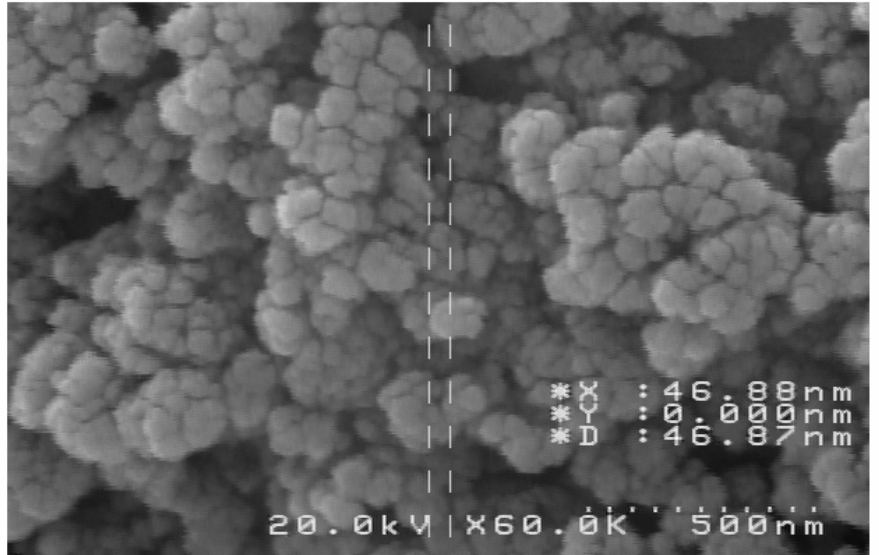
Fig. 3. SEM images of Fe